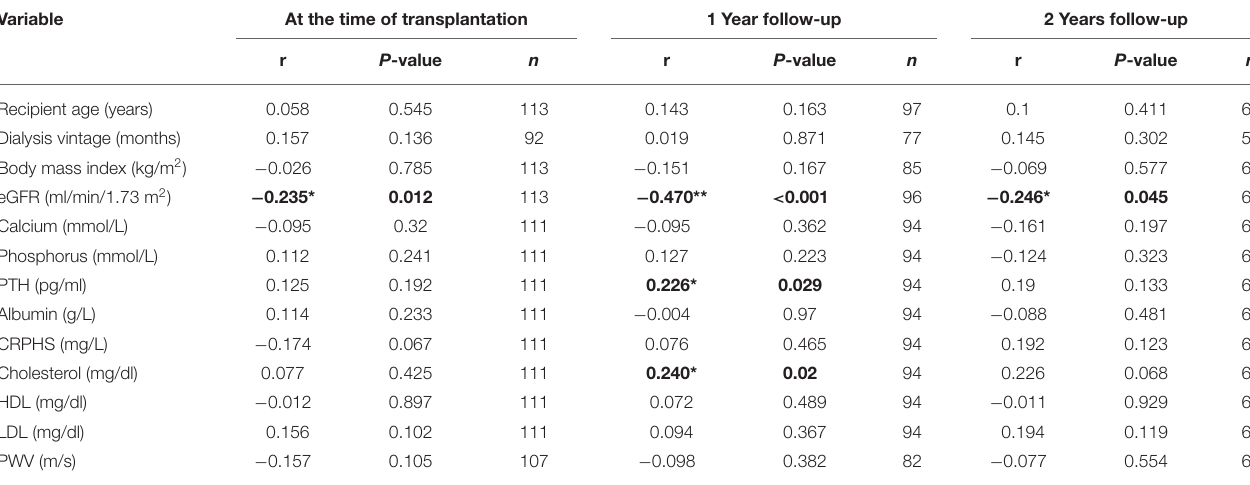
TABLE 2 | Spearman correlations of AZGP1 serum levels and indicated variables for the corresponding time points. Variable